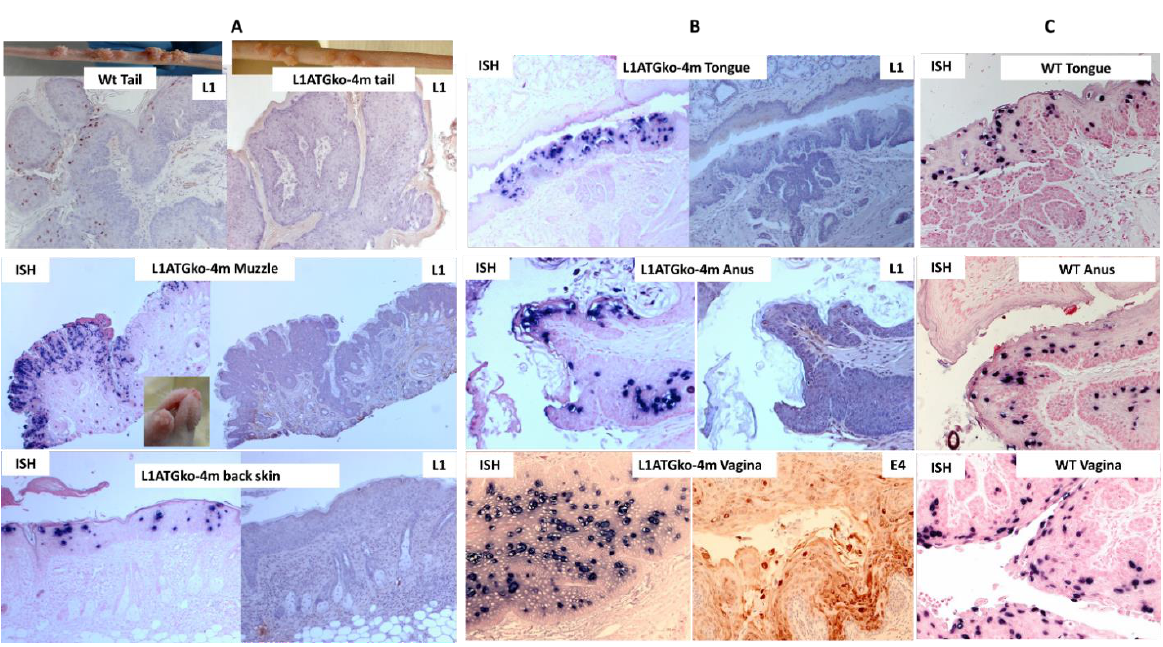
Figure 2. Mouse papillomavirus (MmuPV1) DNA was detected in both cutaneous ( A ) and mucosal ( B ) sites of animals infected with the L1ATGko-4m mutant. Viral capsid protein L1 was strongly positive in the wild-type MmuPV1-induced tail lesion ( A , left L1, 20×) but not in the L1ATGko-4m mutant-induced tail lesion ( A , right L1, 20×) by immunohistochemistry (IHC). Full-length L1 was also absent in other lesions including the muzzle, back skin, anus, and tongue initiated by the L1ATGko-4m mutant by MPV.B9 (L1 panel). Viral DNA expression was strongly positive in representative muzzle lesions ( A , 20×), back skin ( A , 20×), tongue ( B , 20×), anal tract ( B , 20×), and vaginal tract ( B , 20×) by in situ hybridization (ISH), as shown in wild-type tissues ( C , 20×). Interestingly, E4 was moderately to strongly cytoplasmic positive within the vaginal epithelium by immunohistochemistry (IHC) using an in-house rabbit polyclonal antibody against the mouse papillomavirus E4 protein ( B , 20×).